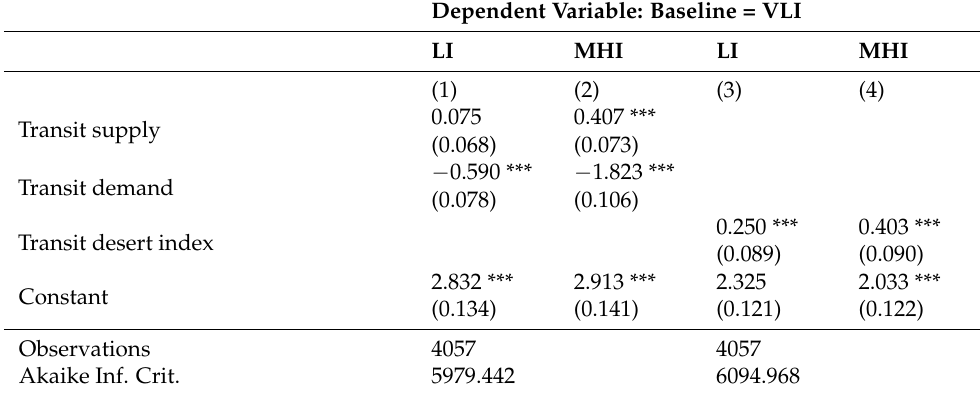
Table 4. Results of logit models by categories.